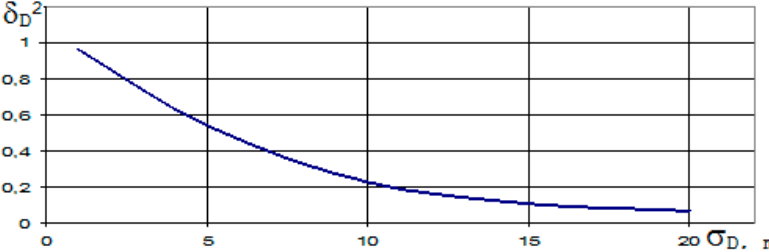
Figure 5. Dependence of the a posteriori standardized dispersion δ D2 (t) on a priori dispersion σ D in the transition process for t = 0.06 s [DPBA].